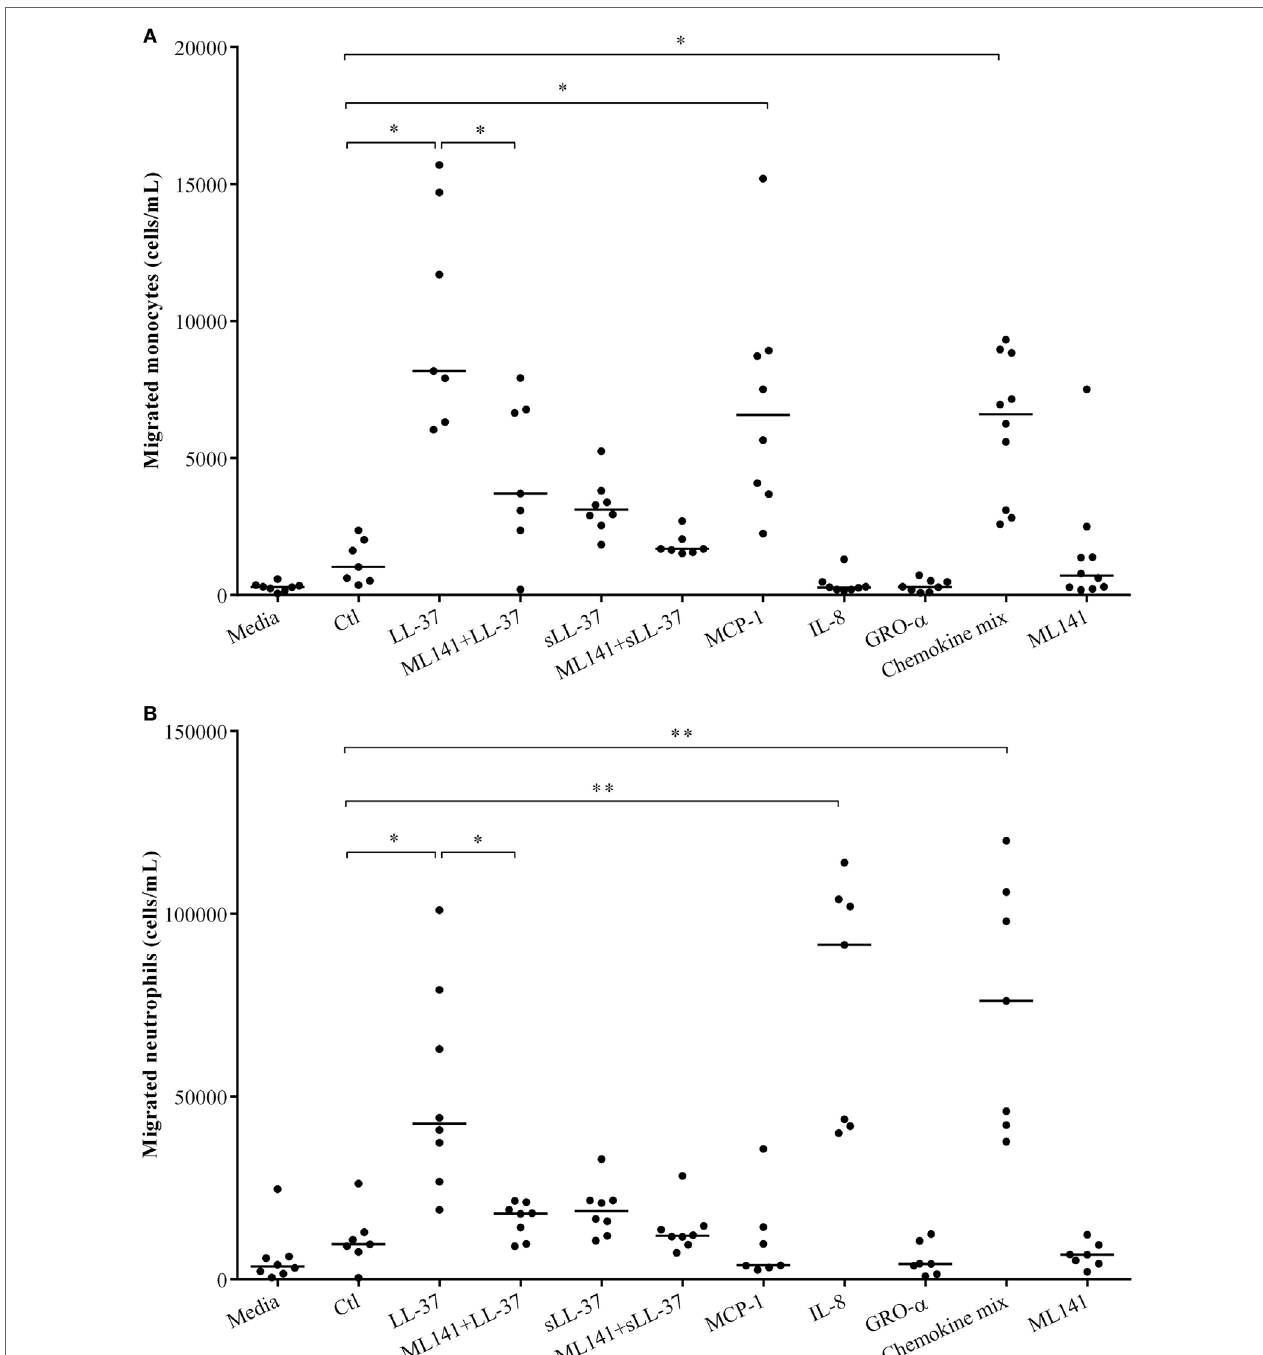
FigUre 6 | Cdc42/Rac1 Rho GTPases controls LL-37-mediated leukocyte migration. Human peripheral blood-derived mononuclear cells (PBMCs) were pre-incubated with the Cdc42/Rac1 inhibitor ML141 (10 µM) for 1 h prior to stimulation with either LL-37 or sLL-37 (5 µM each). PBMC tissue culture supernatants collected after 24 h were used in transwell cell migration assays to monitor the migration of (a) THP-1 monocytic cells and (B) human neutrophils. RPMI medium spiked with chemokines monocyte chemotactic protein-1, IL-8, and GRO- α (30 ng/ml each) were used as experimental controls as indicated. Results shown are from seven independent experiments using PBMCs isolated from independent donors ( n -7). Each dot represents an independent donor and the median line is shown for each condition. Kruskal–Wallis analysis of variance with Dunn’s multiple comparison test was used for statistical analyses (* p < 0.05, ** p < 0.005).